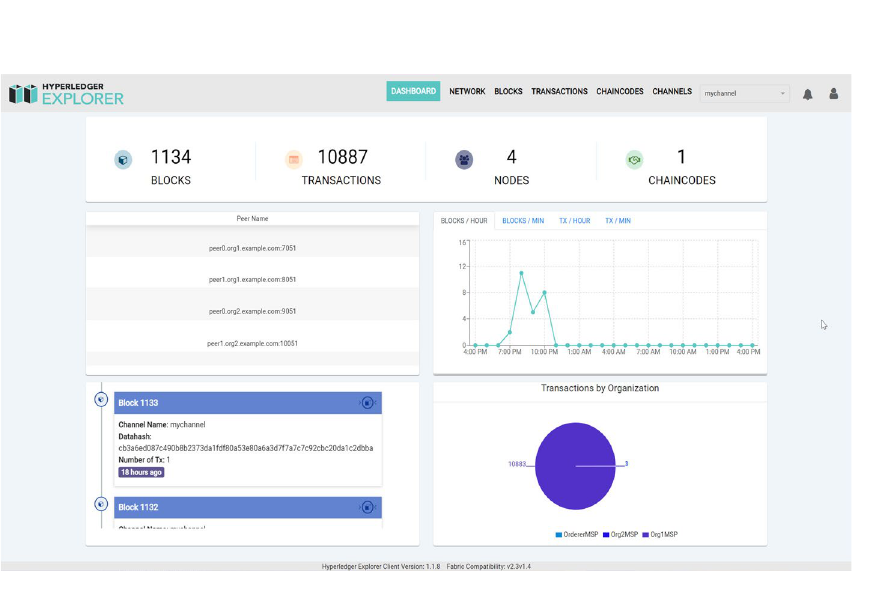
Figure 7. Blockchain